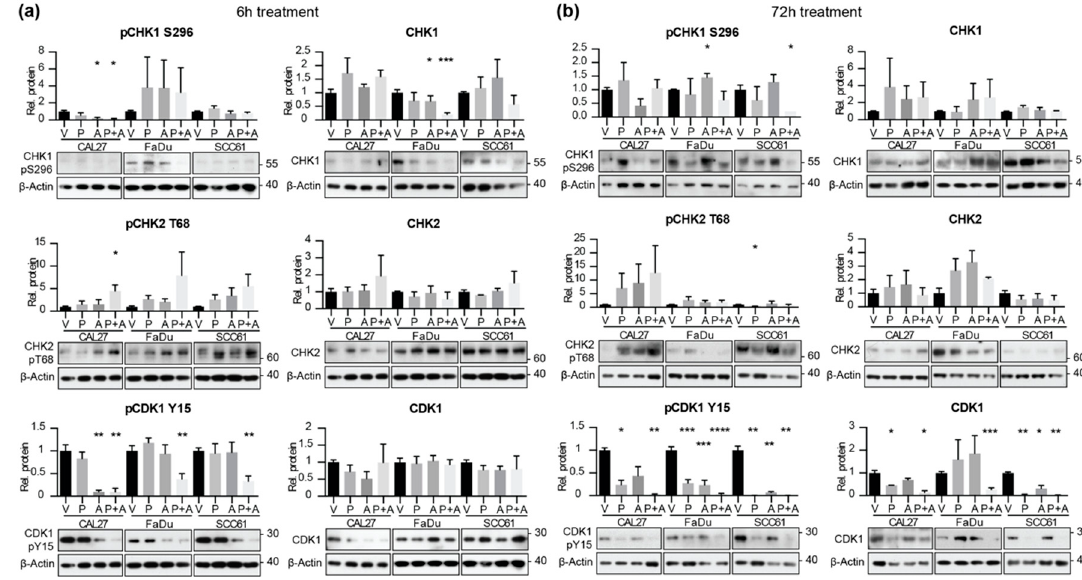
Figure 6. Combined application of prexasertib and adavosertib enhances CDK1 activation. ( a , b ) Quantification (top) and representative western blot images (bottom) for indicated phospho- and total proteins in HNSCC cell lines, after 6 ( a ) or 72 h ( b ) of treatment with indicated drugs. All graphs: *, p ≤ 0.05; **, p ≤ 0.01; ***, p ≤ 0.001, ****, p ≤ 0.0001 relative to vehicle controls.